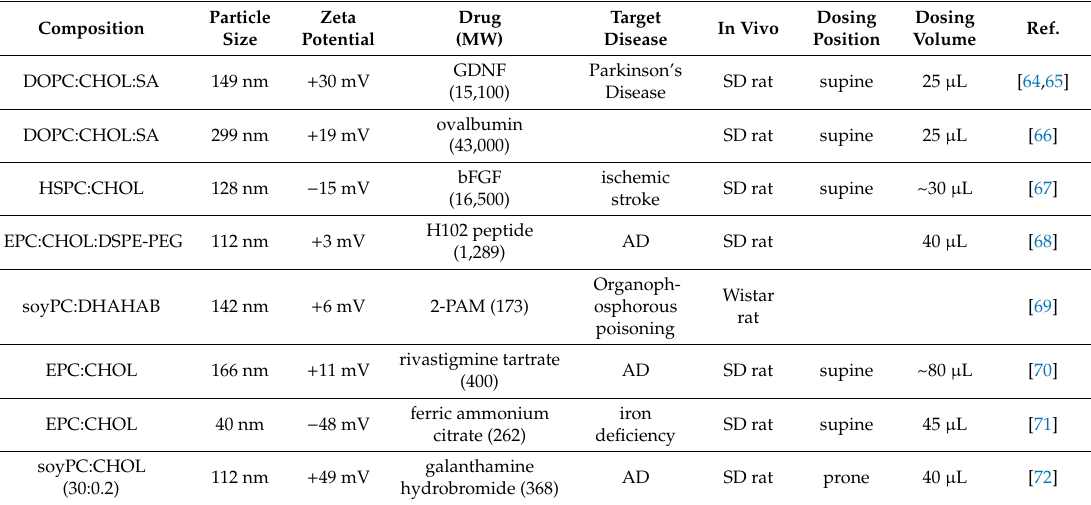
Table 1. Liposomal formulations designed for nose-to-brain delivery of hydrophilic